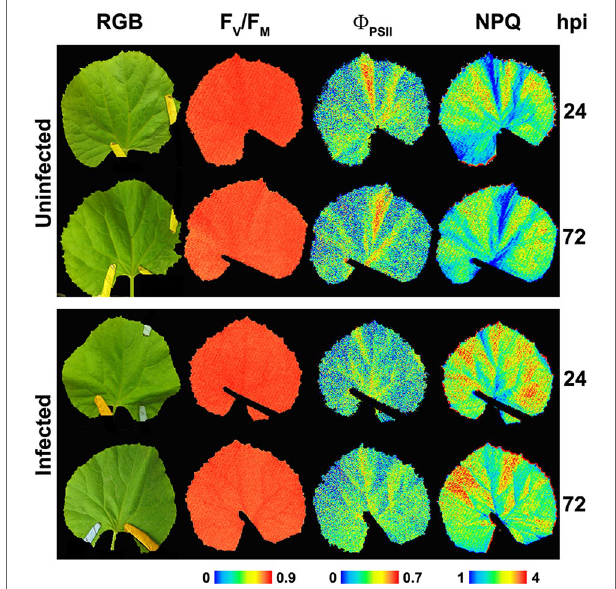
FIGURE 3 | Representative images of the symptomatology (color reflectance pictures, RGB), PSII efficiency (F V /F M and Φ PSII ) as well as non-photochemical quenching (NPQ) from non-infected and Podosphaera xanthii –infected melon leaves at 24 and 72 hours post-infection (hpi). Modified from Polonio et al. (2019) (http://creativecommons.org/licenses/by/4.0/) with